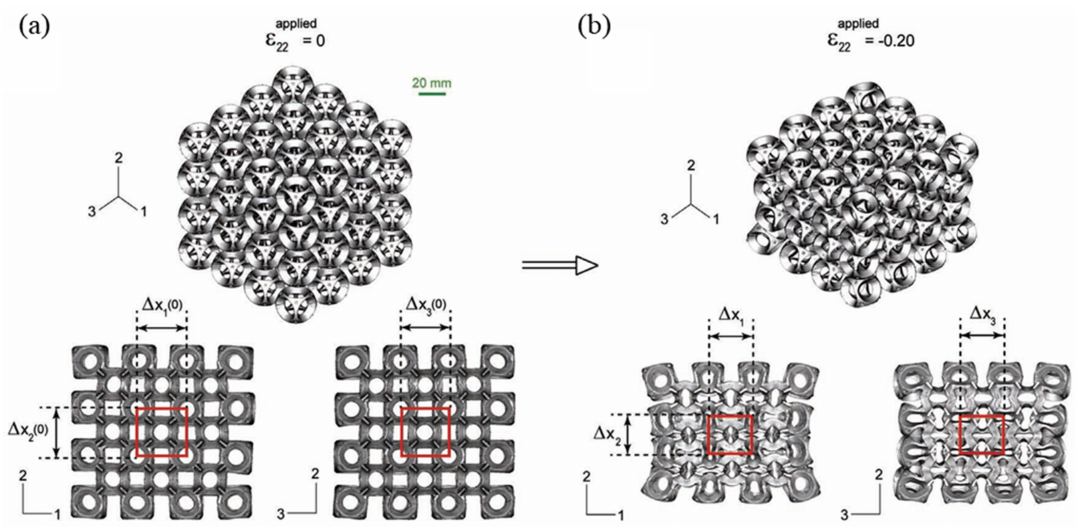
Figure 12. Experimental and numerical image of the 6-hole Bucklicrystal: ( a ) isometric and cross-sectional views of the undeformed crystal from micro-CT (micro computed tomography) X-ray imaging machine, and ( b ) isometric and cross-sectional views of the uniaxially compressed crystal from micro-CT volumetric data sets [71,72].